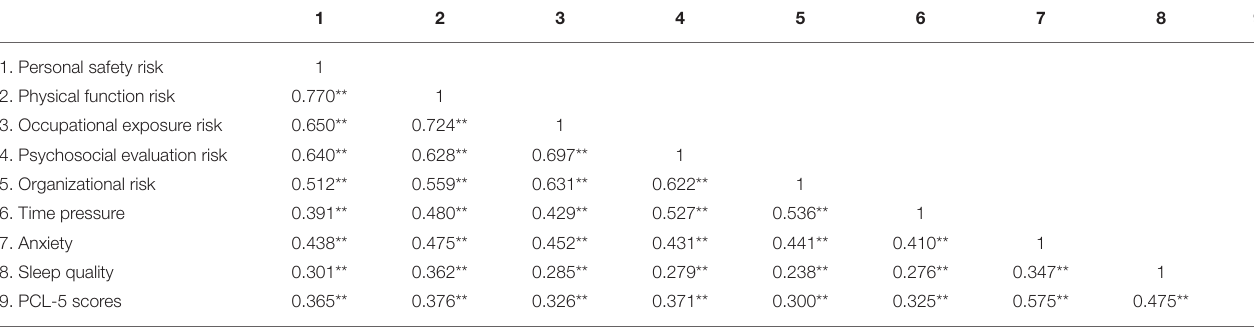
TABLE 3 | Correlations between risk perception, anxiety, sleep quality, and PTSD symptoms.